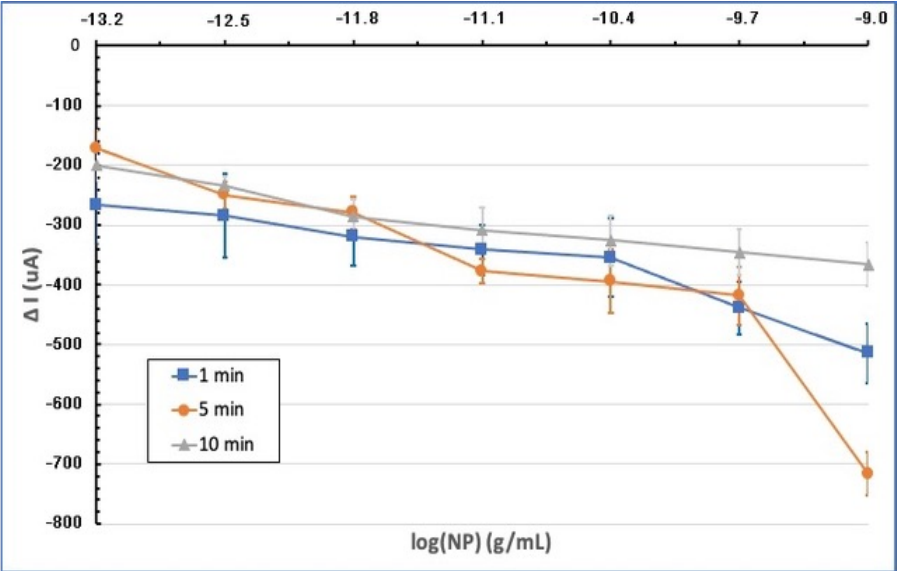
Figure 5. Graph of SWV current suppression ( ∆ I) of the modified electrodes incubated in the range of 6.4 × 10 − 14 g/mL to 1 × 10 − 9 g/mL at different NP concentrations and at different times (1, 5, and 10 min). and 10